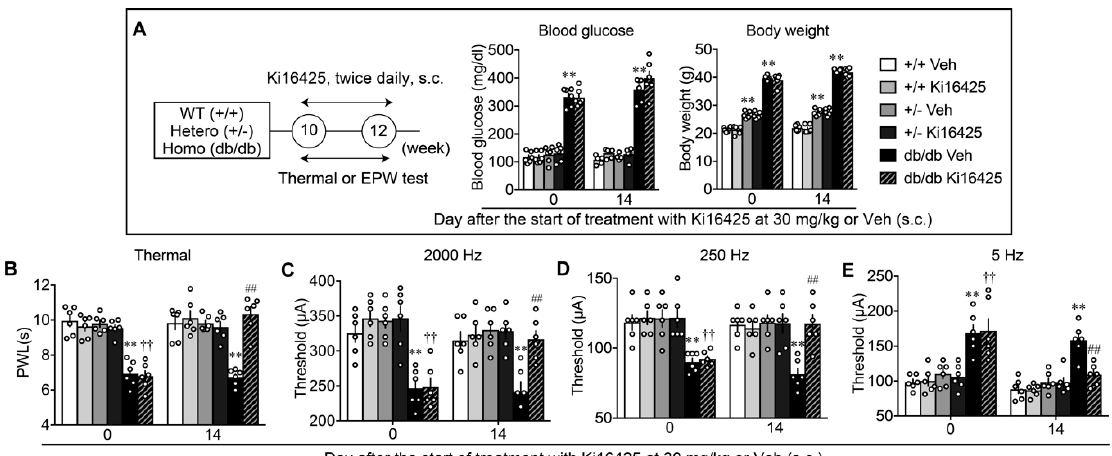
Figure 5. Reversal of abnormal pain behaviors in db / db mice by systemic treatments with LPA 1 / 3 antagonist. ( A ) Experimental schedule and lack of effects on the blood glucose levels and body weight by repeated treatments with Ki16425 (s.c.). ( B – E ) Effects of repeated treatments with Ki16425 on abnormal pain behaviors in WT, leptin-deficient heterozygotes ( +/ –) and db / db mice. Results represent the threshold of PWL (s) in the thermal test ( B ), and currents ( µ A) in the EPW test using 2000 ( C ), 250 ( D ) and 5 Hz ( E ). ** p < 0.01, vs. +/+ Veh, †† p < 0.01, vs. +/+ Ki16425, ## p < 0.01, vs. db / db Veh, two-way ANOVA followed by Tukey’s multiple comparisons test ( n =